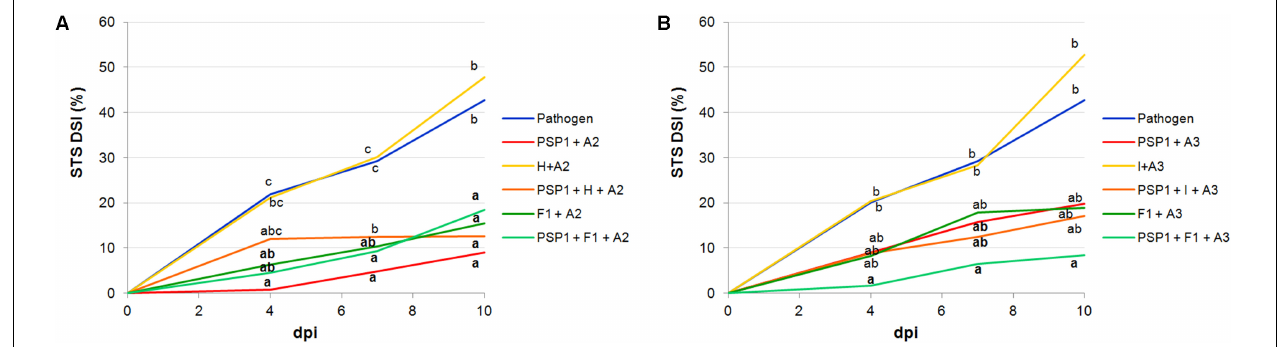
FIGURE 2 | PSP1 compatibility with commercial agrochemical products: insecticide (I), herbicide (H) and fungicide (F1) combined with different adjuvants. The tested mixtures with adjuvant A2 are shown in (A) : PSP1+A2, H+A2, PSP1+H+A2, F1+A2 and PSP1+F1+A2; and those with adjuvant A3 are shown in (B) : PSP1+A3, I+A3, PSP1+I+A3, F1+A3 and PSP1+F1+A3. These mixtures were applied in soybean plants grown under controlled conditions 3 days prior to inoculation with the virulent strain C4 of C. cassiicola (5 × 10 4 conidia/ml) and induced resistance against sobean target spot (STS) was determined. Nine biological replicates (potted